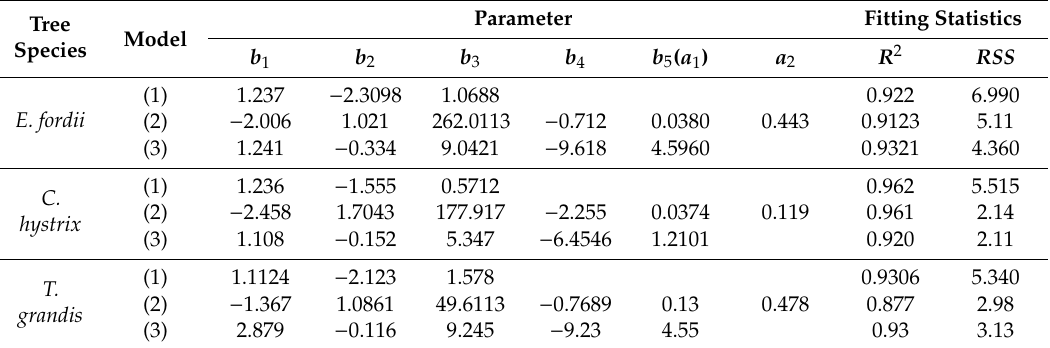
Table 3. Parameter estimates and fit statistics for taper model of E. fordii , C. hystrix and T. grandis.